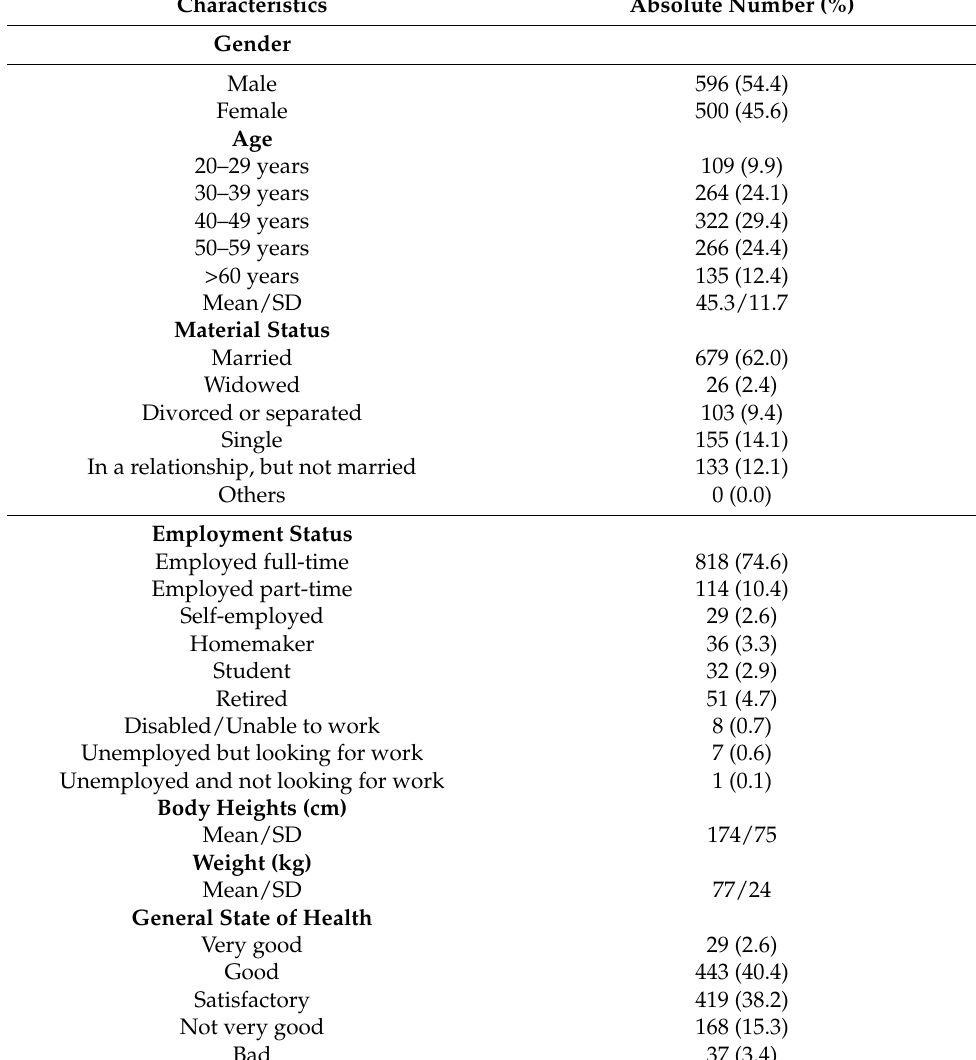
Table 2. Socio-demographic characteristics of the study